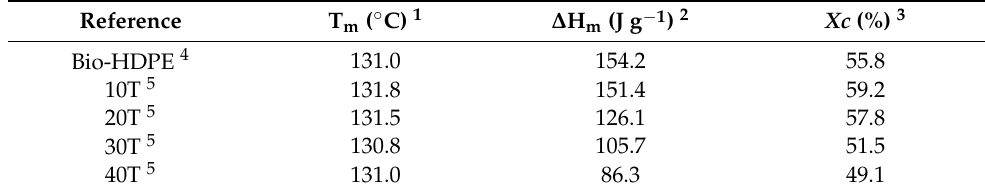
Table 5. Main thermal parameters of Bio-HDPE with different weight percentage of treated chia seed flour with APS obtained using DSC.